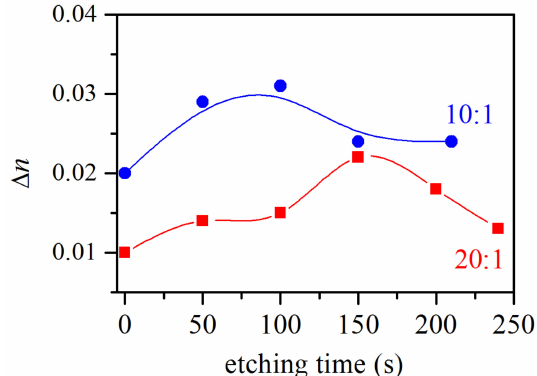
Figure 9. Refractive index change as a function of etching time of hard-templated films of Nb 2 O 5 obtained by liquid phase mixing of Nb sol and silica colloids in different volume ratios indicated in the